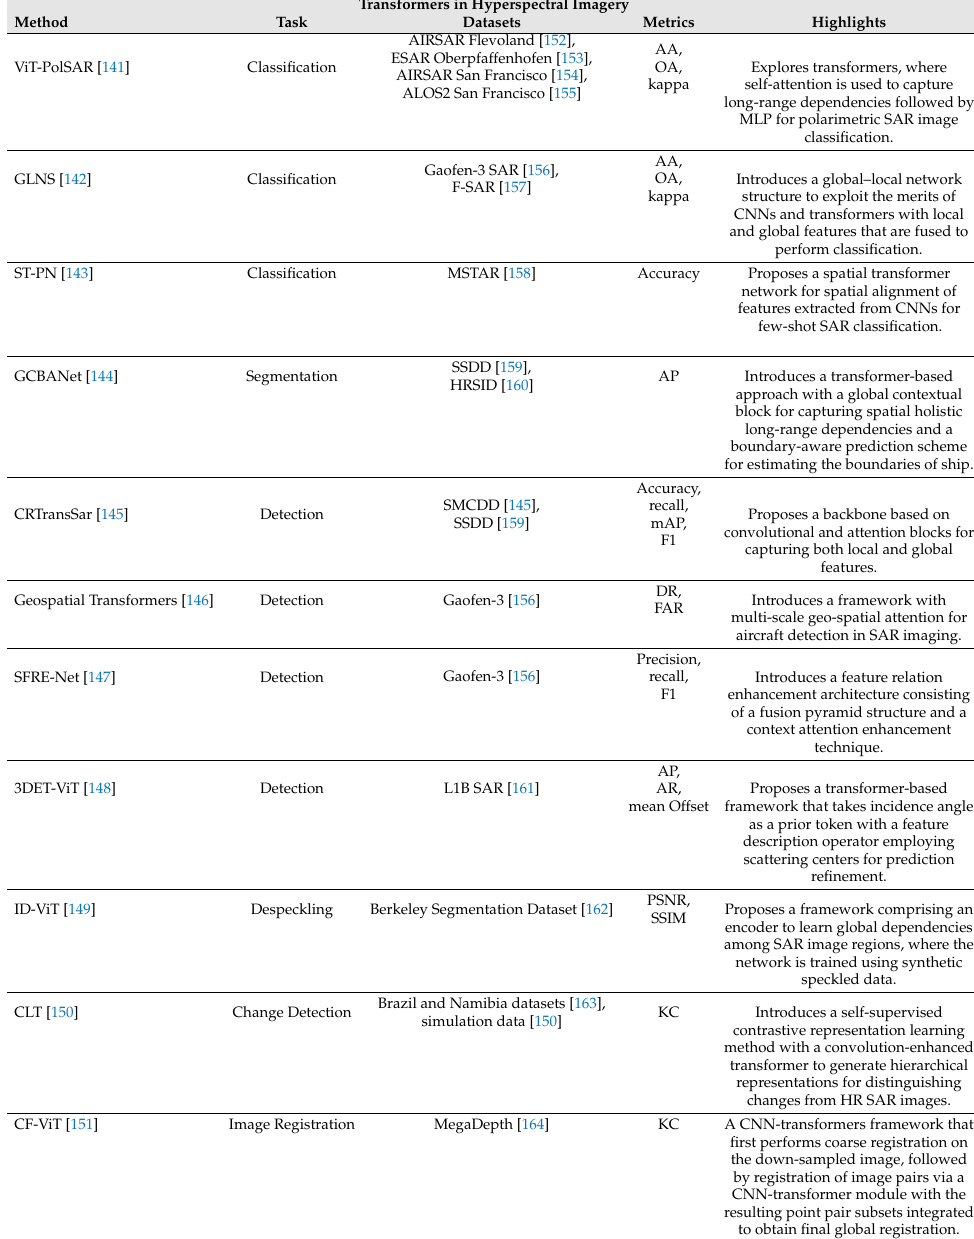
Table 9. Overview of transformer-based approaches in SAR imaging. Here, we highlight methods for different SAR remote sensing